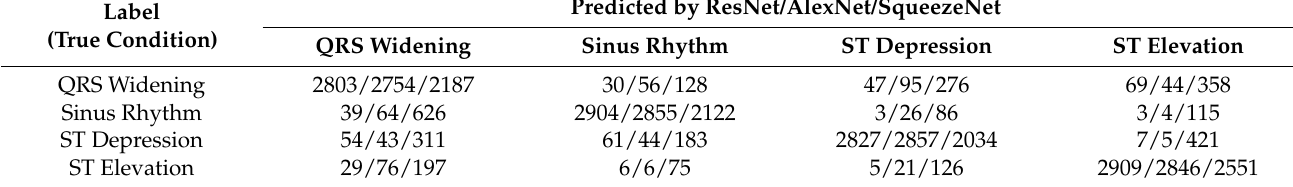
Table 2. The confusion table with true positives, true negatives, false positives, and false negatives in four categories predicted from ResNet, AlexNet, and SqueezwNet.